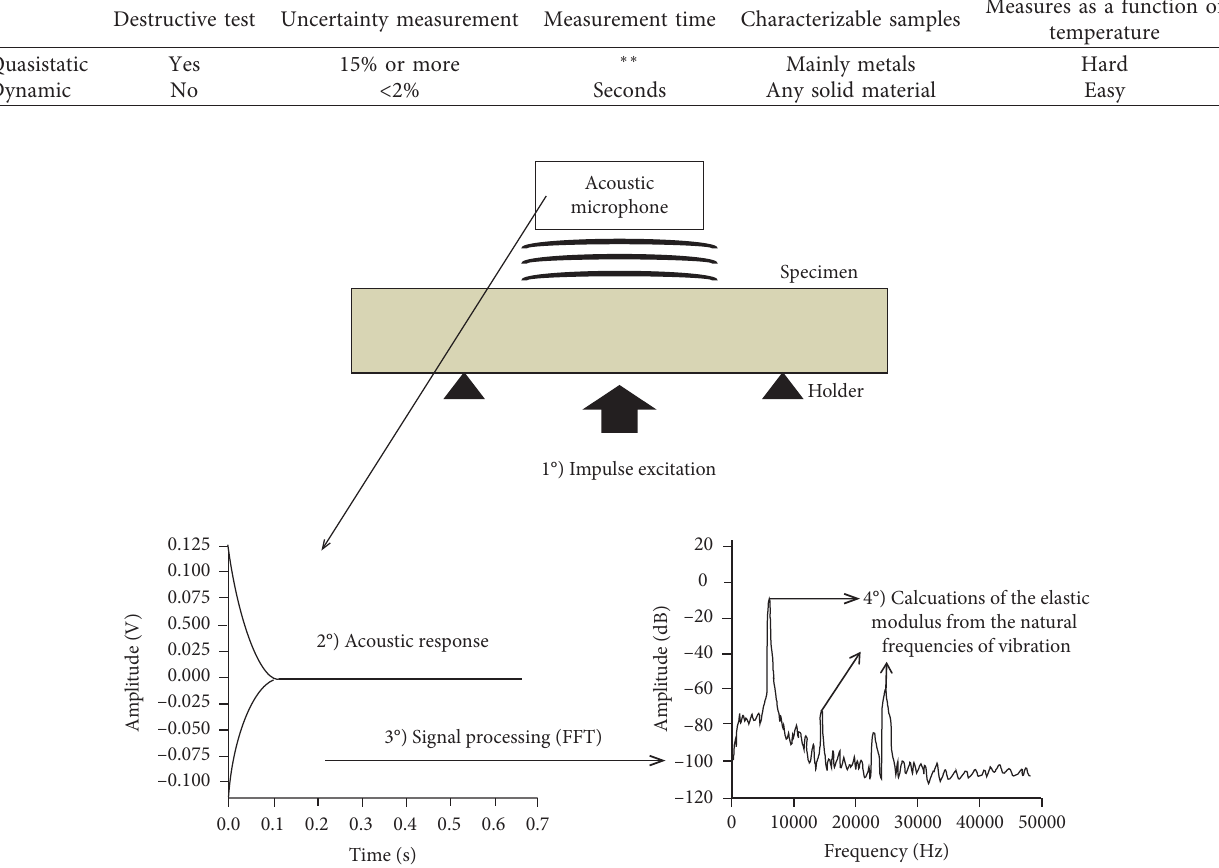
Figure 1: Determination of Young’s modulus by the Impulse Excitation Technique